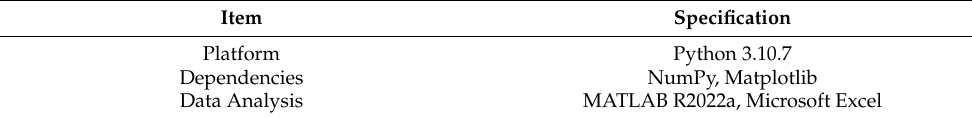
Table 4. Software specification.